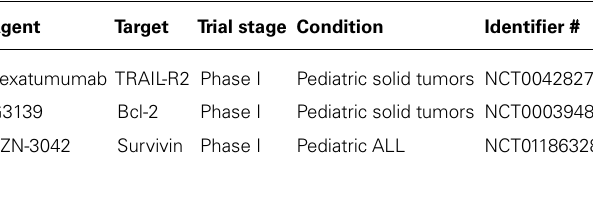
Table 2 | Examples of clinical trials targeting apoptosis pathways in pediatric cancers.